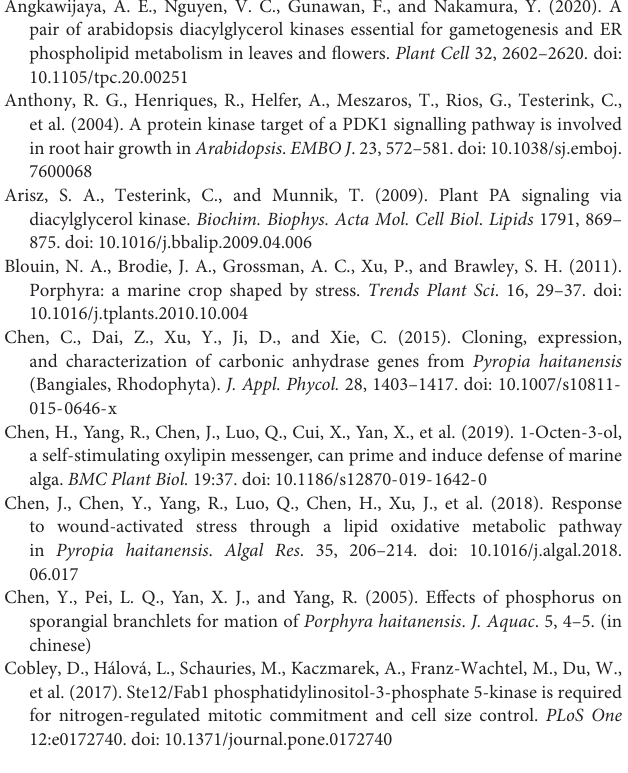
Supplementary Figure 3 | Hierarchical clustering of PI signal system. Red: up-regulation; Blue: down-regulation. Transcript levels of genes are shown as fold changes of RPKM compared with that at S-1-0 or S-2-0.